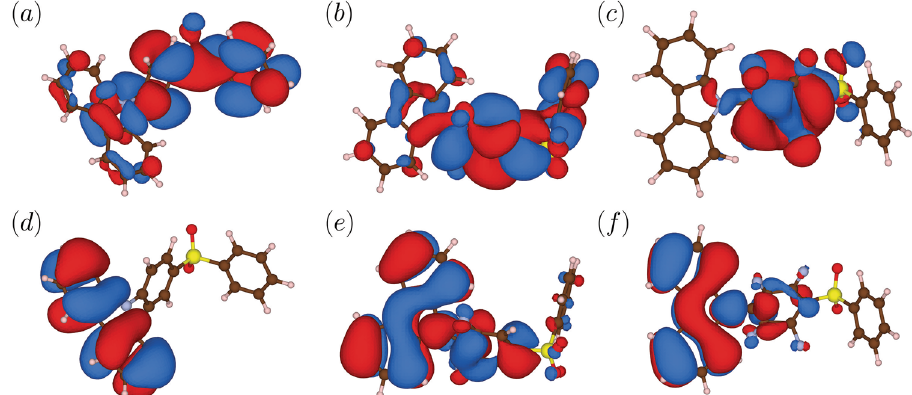
Fig. 2 Frontier molecular orbitals of the triplet state optimized structures of PSPCz molecules. LUMO ( a – c ) and HOMO ( d – f ) orbitals of PSPCz ( a , d ), 2F-PSPCz ( b , e ) and 4F-PSPCz ( c , f ),